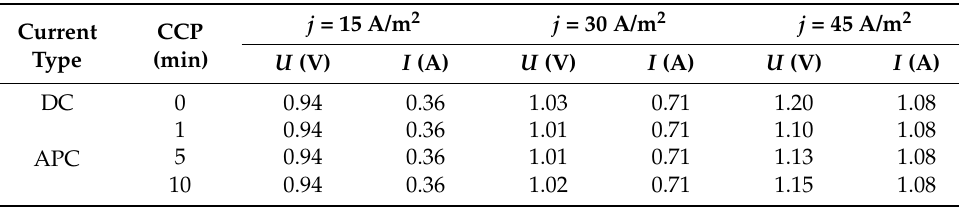
Table 1. Operating parameters of the EC reactor